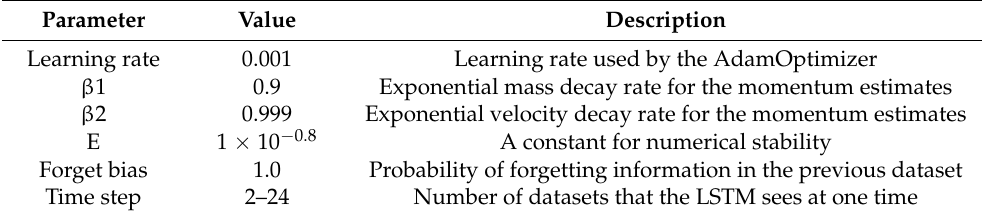
Table 1. Hyperparameters for the recurrent neural network (RNN) and AdamOptimizer.